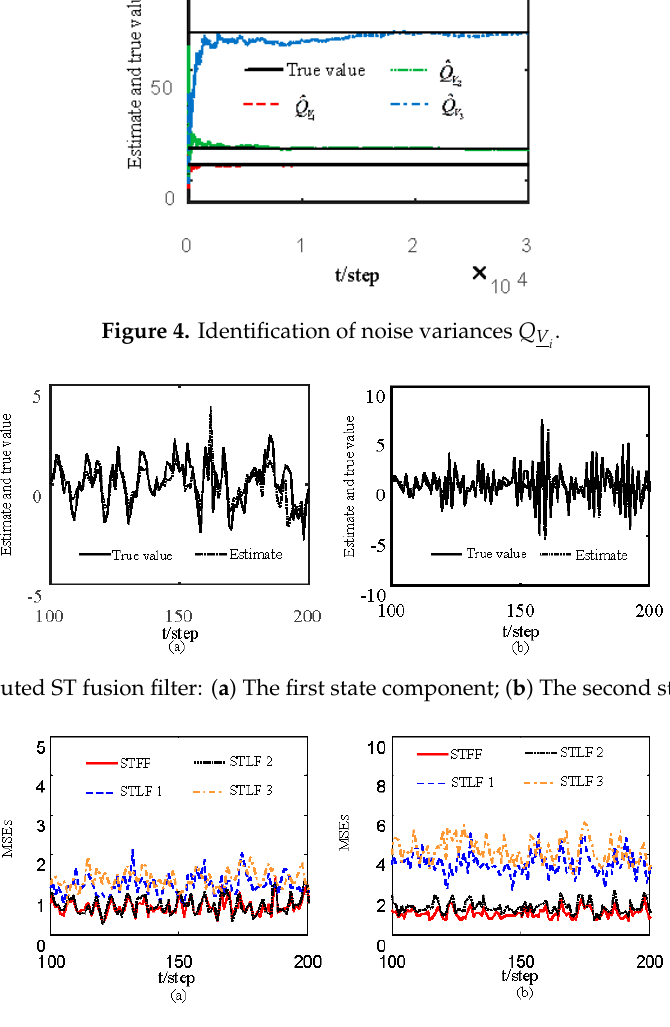
Figure 6. Comparison of MSEs of ST fusion filter and ST local filters: ( a ) The first state component; ( b ) The second state component.